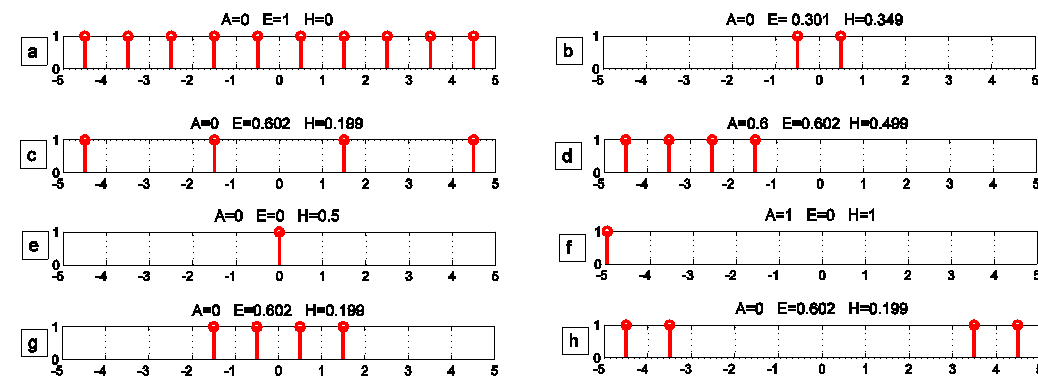
Figure 3. Examples of artificial distributions and their characterization by asymmetry A , entropy E , and inhomogeneity measure H , Eq. (1). Fig. 3. Examples of artificial distributions and their characterization by asymmetry A , entropy E , and inhomogeneity measure H , Eq.(1). years 2005–2009. The ozone field was simulated with a high resolution of 1.5 ◦ in latitude and 3 ◦ in longitude. Then the monthly mean model data in 10 ◦ latitude bins from 90 ◦ S Fig. 3. Examples of artificial distributions and their characterization by asymmetry A , to 90 ◦ N were compared with those sampled according to entropy E , and inhomogeneity measure H , Eq.(1). the locations of the satellite measurements. An example